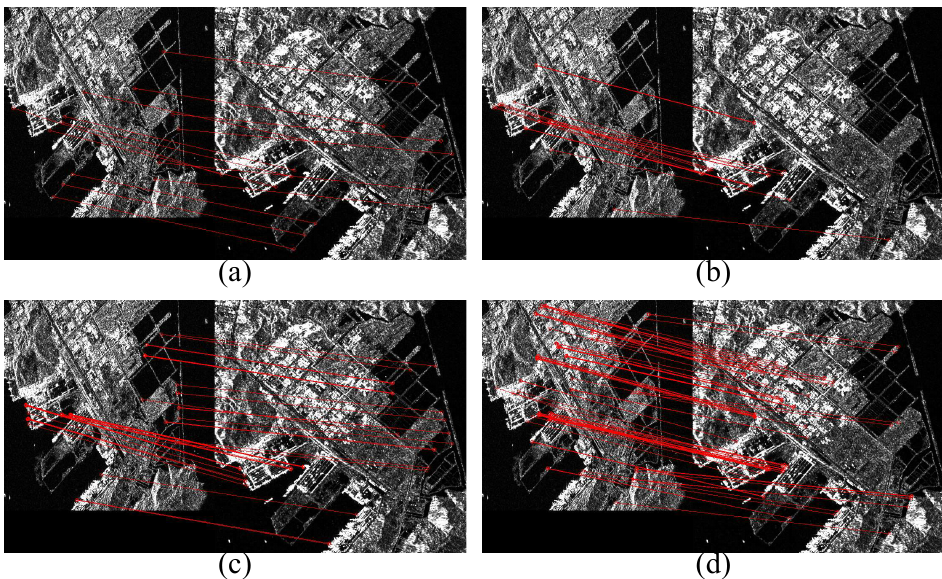
Figure 17. The feature descriptor matching results with different methods for pair 6. ( a )